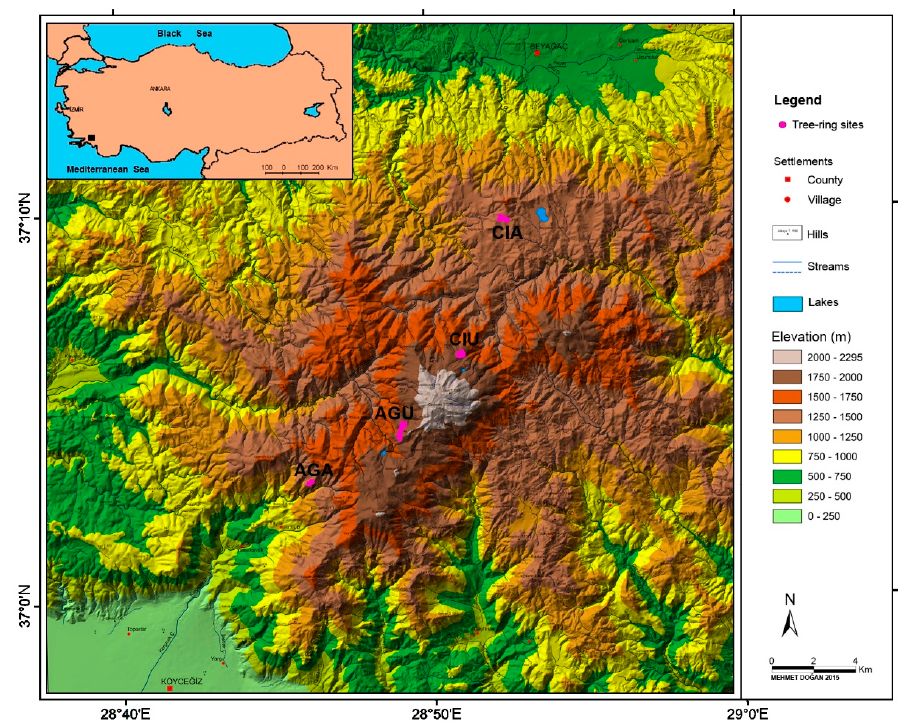
Plants 2019 , 8 , x Figure 8. Location of sampling sites on Sand ı ras Mountain (magenta areas). Figure 8. Location of sampling sites on Sandıras Mountain (magenta areas).